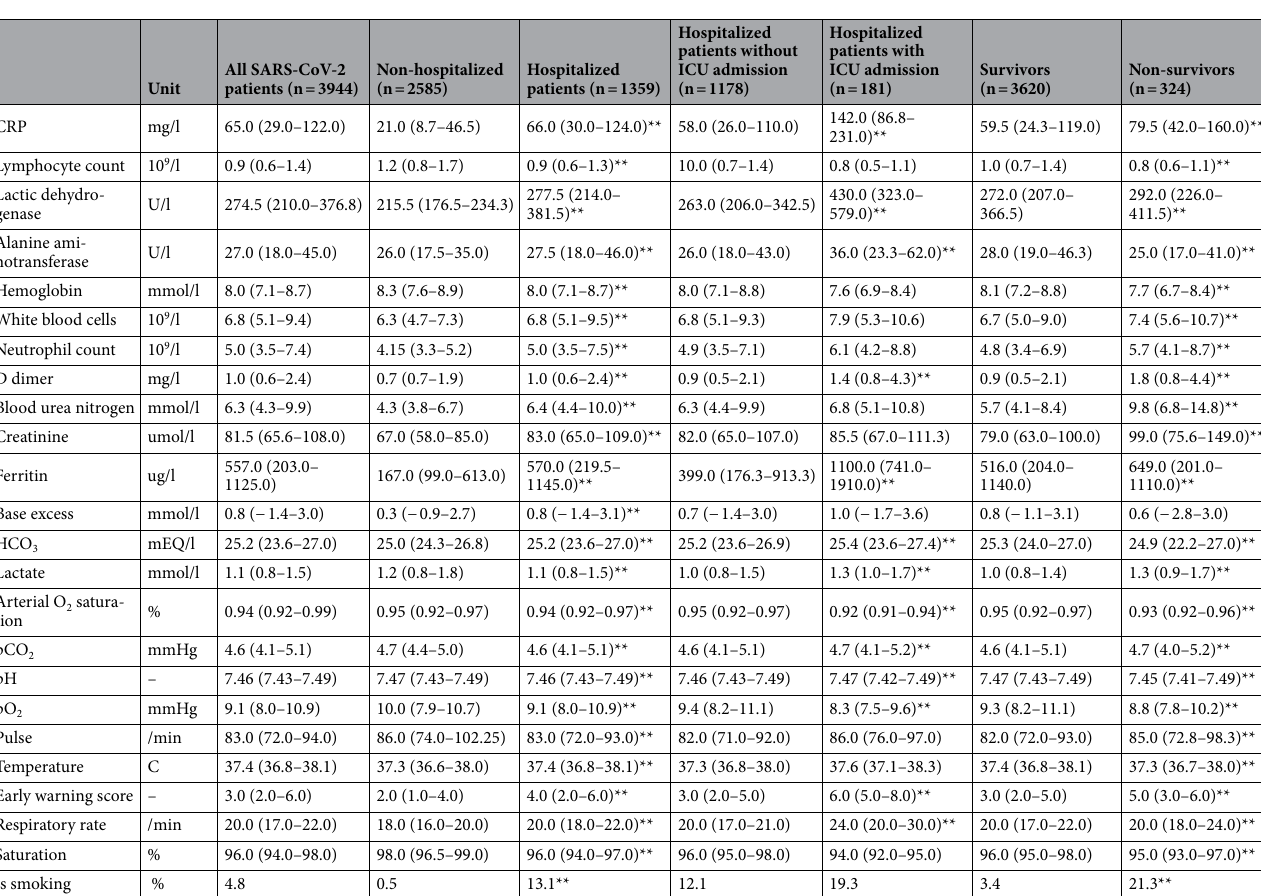
Table 2. Temporal features (laboratory tests and vital signs). The table presents information on the full cohort (admitted and non-admitted SARS-CoV-2 positive patients) as well as subgroups admitted to a hospital and Intensive Care Unit (ICU) respectively. Furthermore, differential temporal features between survivors and non-survivors (in-hospital mortality) is presented. Continuous variables are presented as medians with (interquartile range). ** p < 0.001 when subgroups are compared (e.g. hospitalized vs. non-hospitalized, ICU vs. non-ICU, survivors vs.